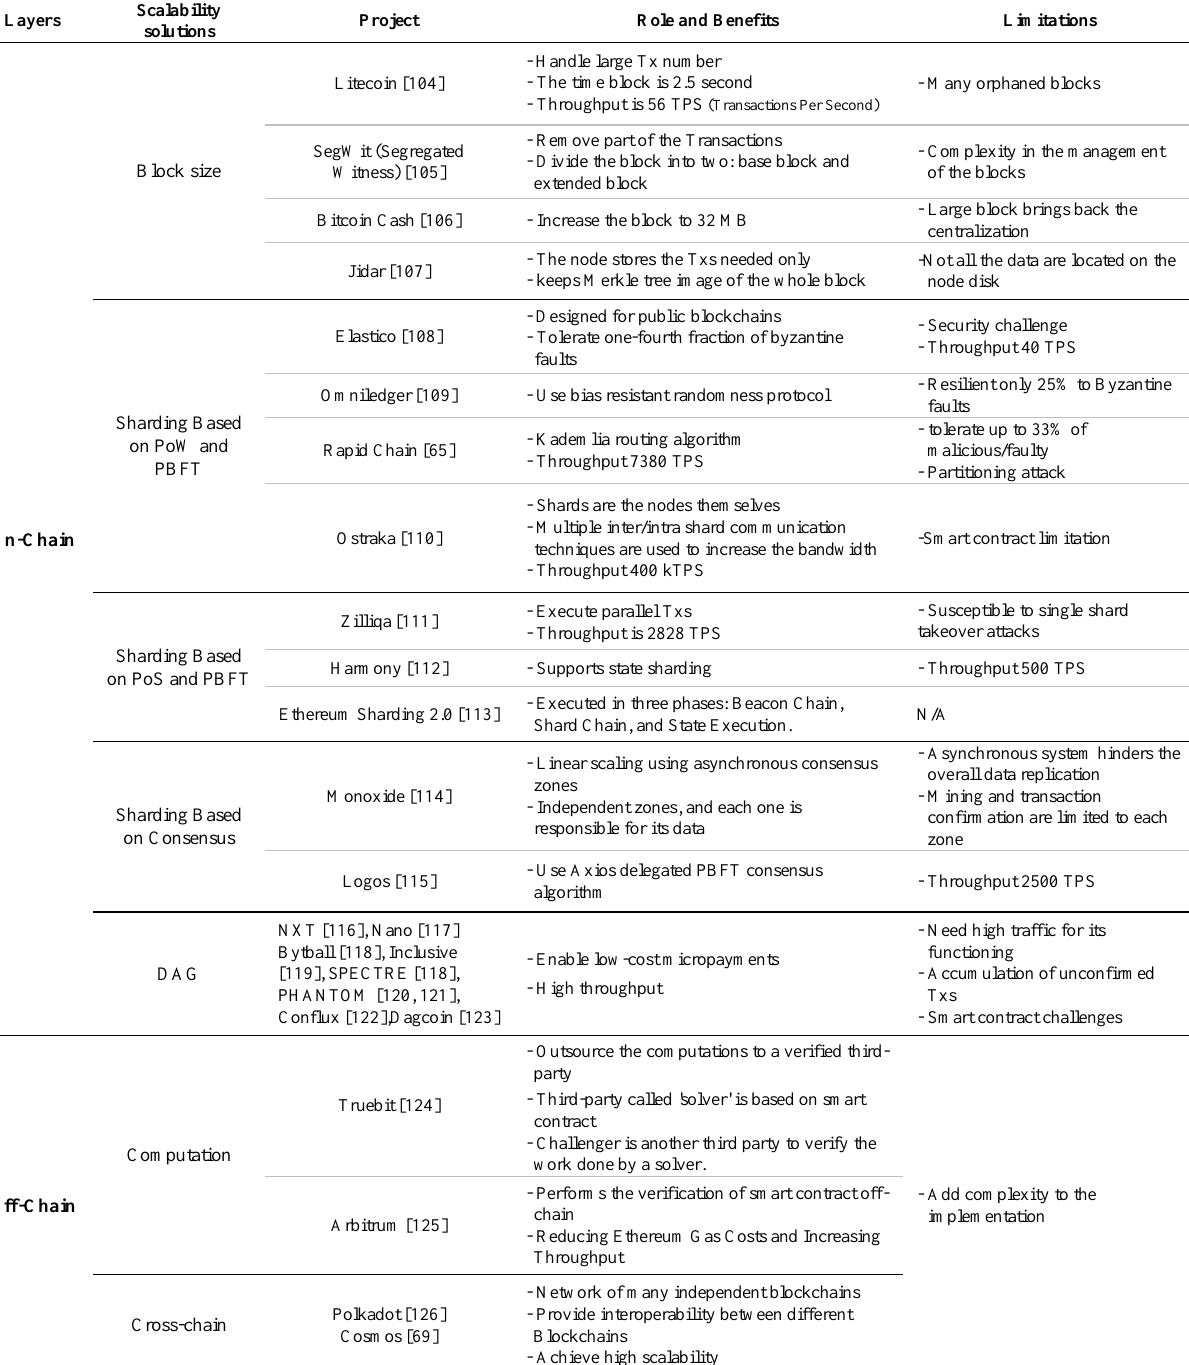
Table 6. Scalability solutions outside the supply